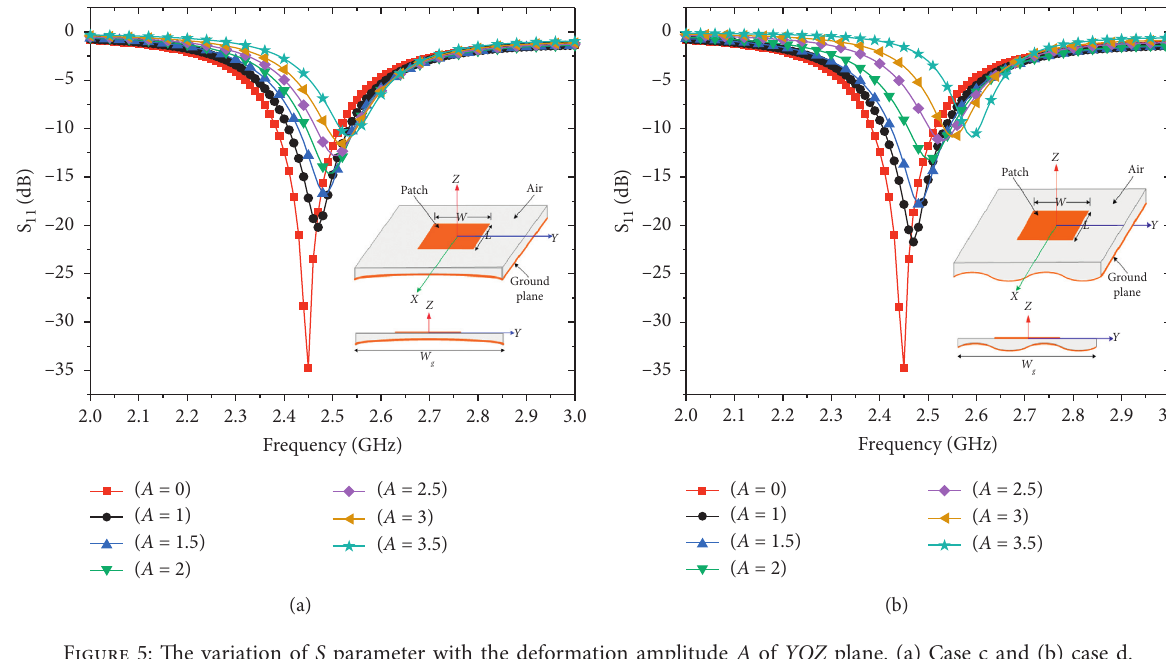
Figure 5: The variation of S parameter with the deformation amplitude A of YOZ plane. (a) Case c and (b) case d.